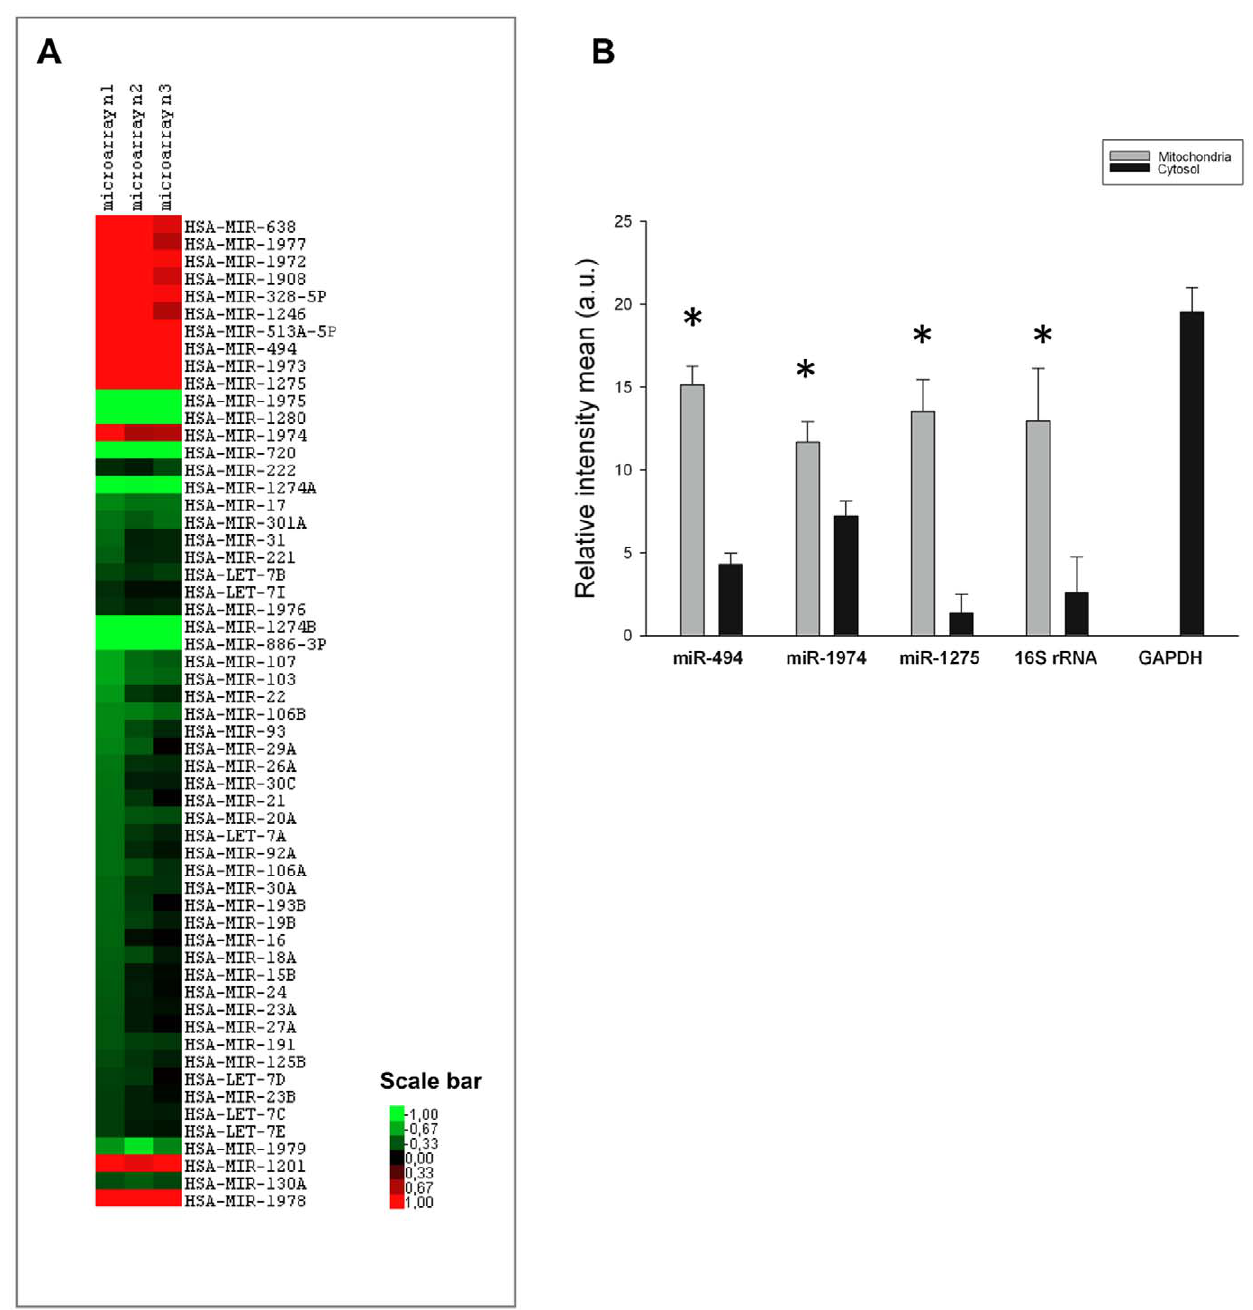
Figure 5. Evidence for a mitochondrial miRNA signature in HeLa cells. A. Heatmap showing the 57 miRNAs differentially expressed in HeLa cells from mitochondrial and cytosolic RNA. Three independent microarray profiling experiments (microarray n1, n2 and n3) are shown and reproducibly revealed 13 miRNAs enriched in mitochondrial RNA. Log2 Hy5/Hy3 ratios are color scaled in gradient from green (low levels) to red (high levels) as indicated by the scale bar. B. Validation of microarray data by RT-PCR. Five genes (hsa-miR-494, hsa-miR-1974, hsa-miR-1275, 16S rRNA and GAPDH ) were selected for microarray data validation of differential expression in either subcellular compartment. 16S rRNA was used as a positive mitochondrial control, while GAPDH as a negative mitochondrial control. Quantitative analysis of band intensities are shown for three independent RT-PCR experiments and indicated as arbitrary units (a.u.) in either mitochondria (grey) or cytosol (black). Error bars represent the standard error of the mean. Asteriscs indicate statistically significant differences as compared to the cytosol (hsa-miR-494, p-value=3.32 6 10 2 5 ; hsa-miR-1974, p- value=0.02; hsa-miR-1275, p-value=6 6 10 2 4 ; 16S rRNA, p-value=0.03).